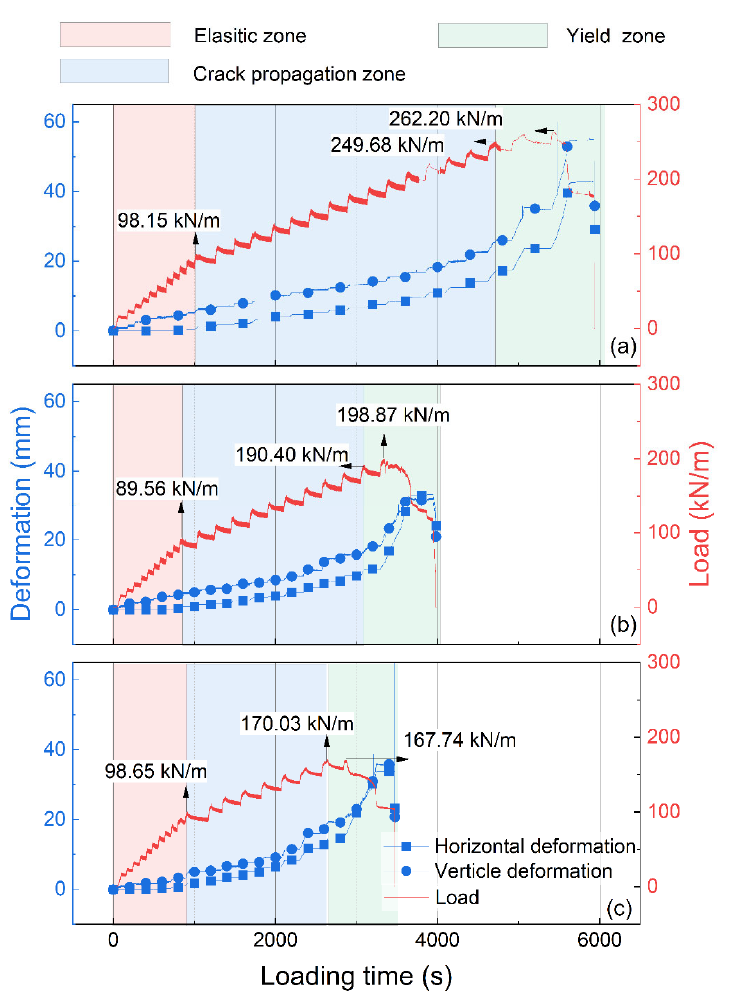
Figure 10. Evolution of force and displacement of a concrete pipe with inner diameter of 1000 mm when performing a three-edge bearing test, where ( a – c ) represents the pipe without wall loss, with 15-mm, and with 25 mm wall loss, respectively.